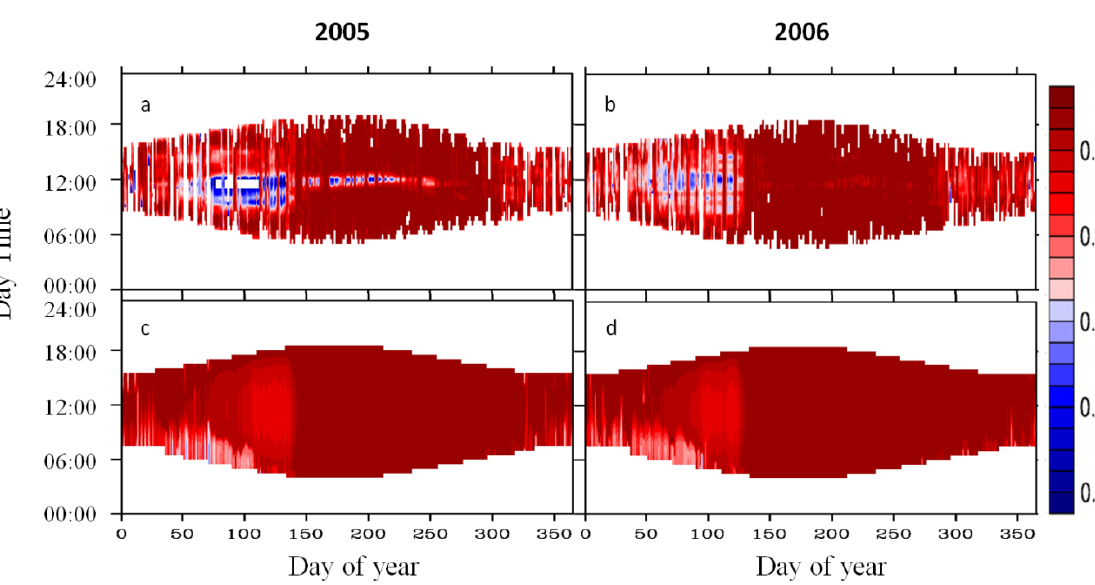
Figure 2. Comparisons of fraction of absorbed photosynthetically active radiation (FPAR) diurnal cycles between Bartlett Experimental Forest flux tower observation (( a ) for 2005 and ( b ) for 2006) and Community Land Model version 4 (CLM4) (( c ) for 2005 and ( d ) for 2006). Cloudy and rainy days, observations with incident PAR lower than 50 μmol/(m 2 ∙s) are removed in the site data. For comparison, data sets are normalized to show the diurnal